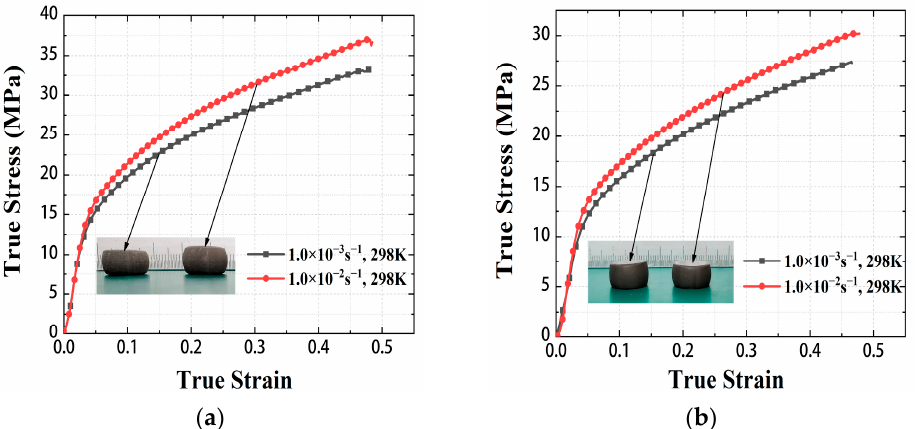
Figure 3. Stress-strain curves of Zr/PTFE, Ti/PTFE under quasi-static compression. ( a ) Zr/PTFE, ( b ) Ti/PTFE.